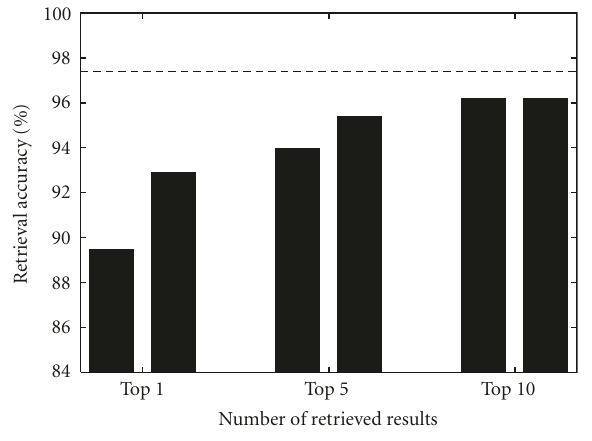
Figure 5: Retrieval accuracy using five words.